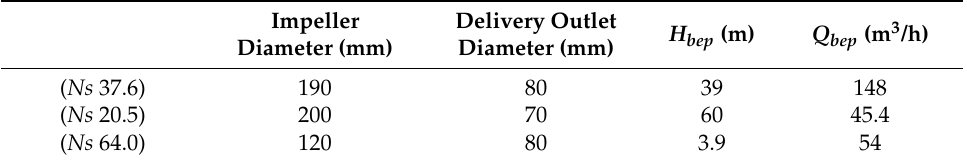
Table 1. It was decided to use pumps with different heads (from 3.9 to 60 m) and flow rates (from 45.4 to 148 m 3 /s) to have different geometries and operating conditions to better test the prediction method. Table 1. Pumps